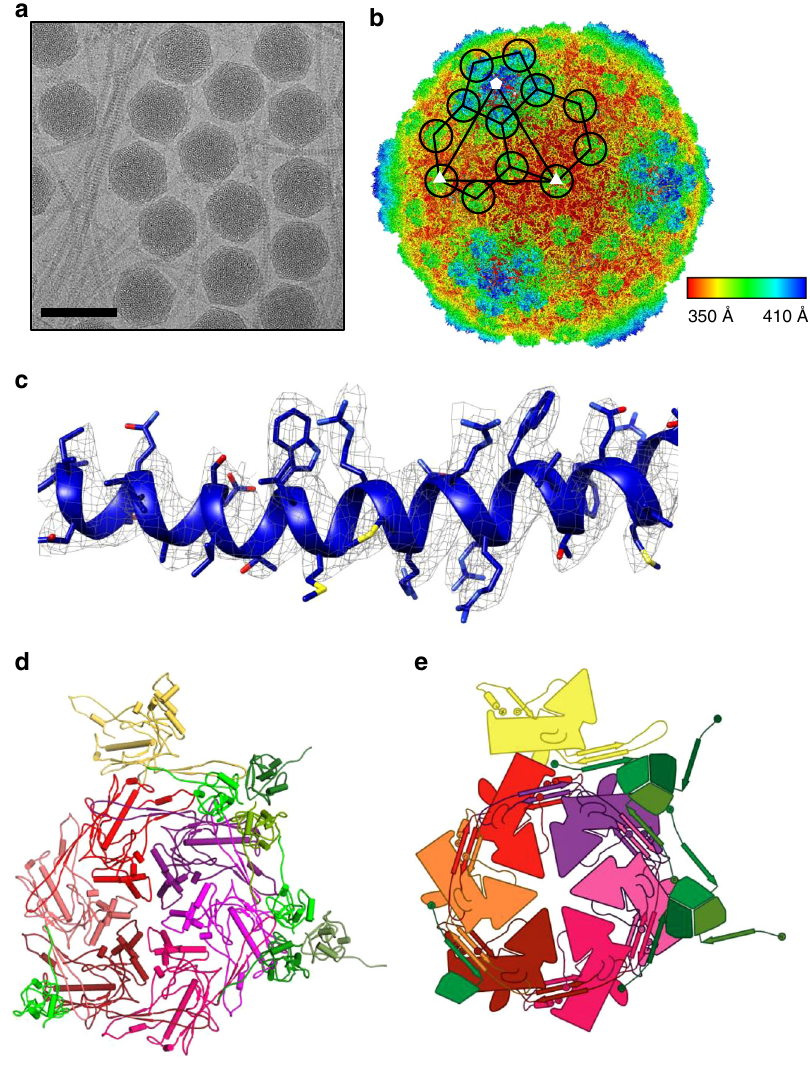
Fig. 2 Determination of P74-26 capsid structure by cryo-EM. a Representative micrograph of puri fi ed P74-26 virions from high-resolution data collection; scale bar, 100 nm. b Icosahedral reconstruction of P74-26 mature capsid, colored radially from the center of the volume (red to blue). One penton and two hexons of MCP are outlined on the volume, and decoration protein trimers are circled. The black triangle indicates the icosahedral asymmetric unit, with three- and fi vefold axes labeled as small white triangles and pentagons, respectively. c Representative section of the density map with fi tted model of the MCP P-domain spine helix. d , e Atomic model of P74-26 icosahedral asymmetric unit ( d ) and corresponding cartoon schematic ( e ). In the asymmetric unit, the Major Capsid Protein (MCP) comprises one complete hexon (shown in shades of red) and a single penton subunit (yellow). The Decoration protein subunits (gp87) are shown in shades of